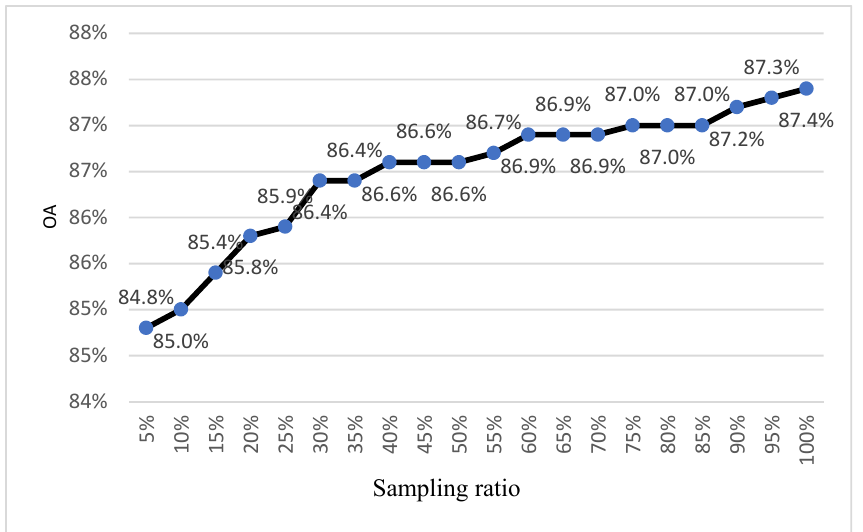
Figure 10. The relationship between sampling rate and overall classification accuracy.